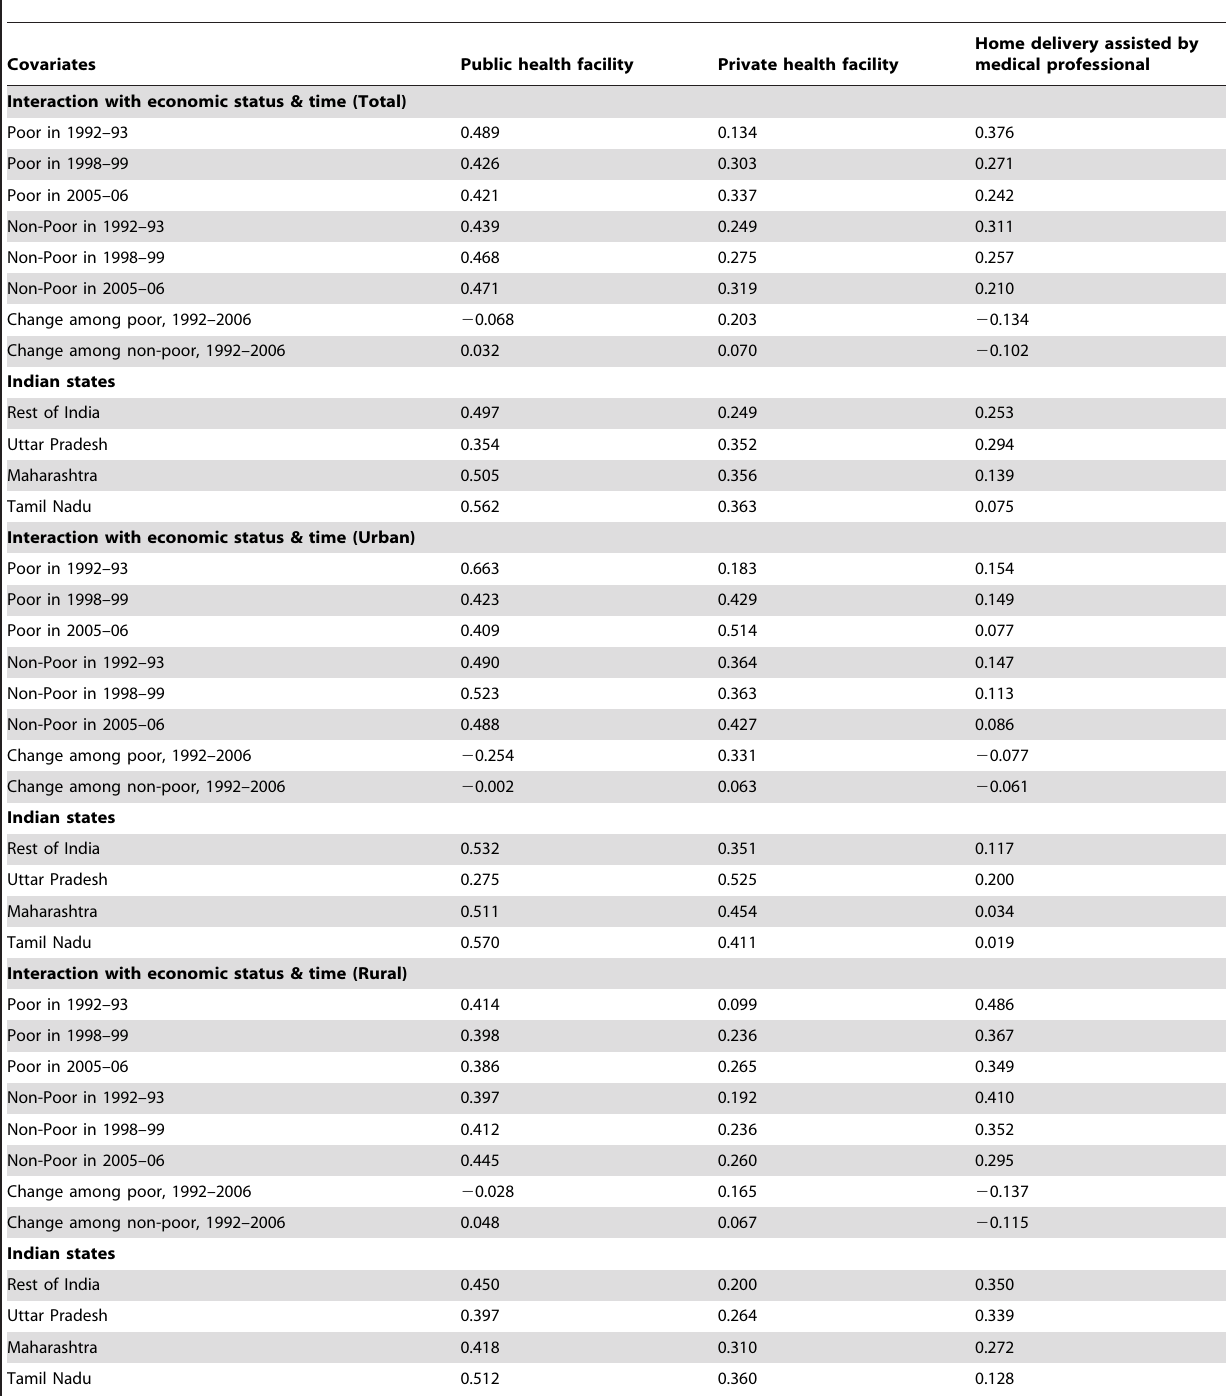
Table 8. Predicted probabilities of birth delivery choice adjusted for socioeconomic and demographic characteristics, India, 1992– 2006 {